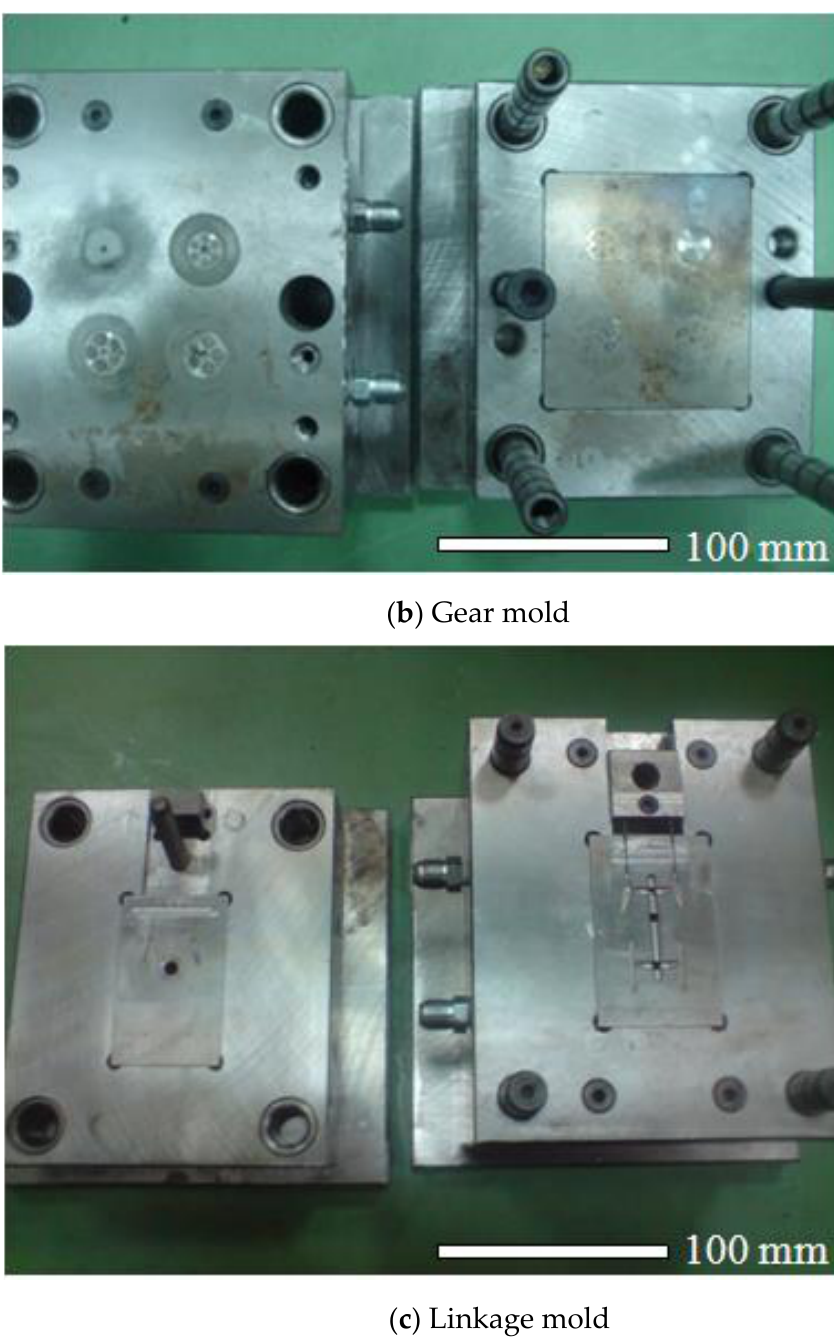
Figure 4. Molds for flapping-wing MAV.